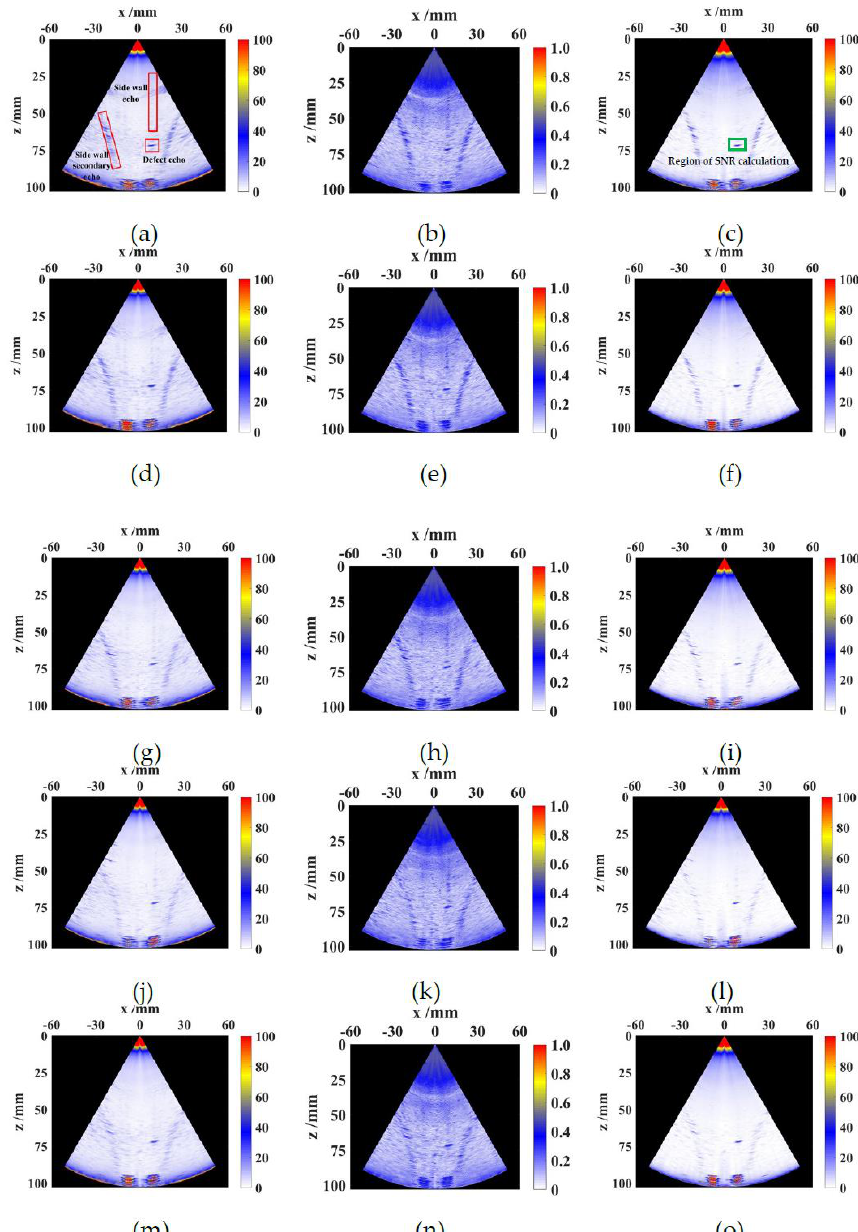
Figure 7. Imaging results of groove with depth 0.1 mm and buried depth 70 mm. ( a ) DAS, ( b ) VCF, and ( c ) DAS_VCF with focus depth 30 mm; ( d ) DAS, ( e ) VCF, and ( f ) DAS_VCF with focus depth 40 mm; ( g ) DAS, ( h ) VCF, and ( i ) DAS_VCF with focus depth 50 mm; ( j ) DAS, ( k ) VCF, and ( l ) DAS_VCF with focus depth 60 mm; ( m ) DAS, ( n ) VCF, and ( o ) DAS_VCF with focus depth 70 mm.